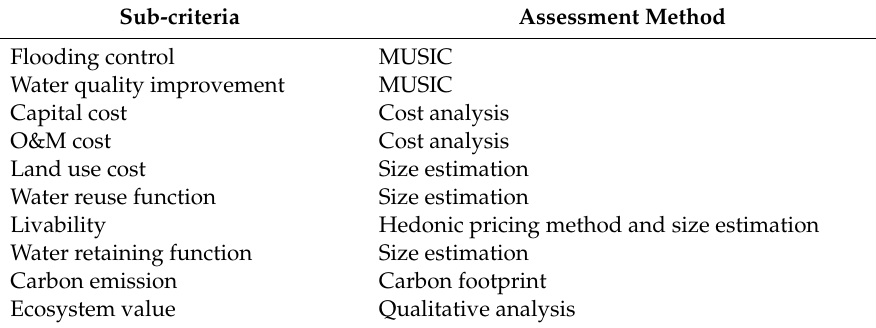
Table 7. The assessment methods for individual